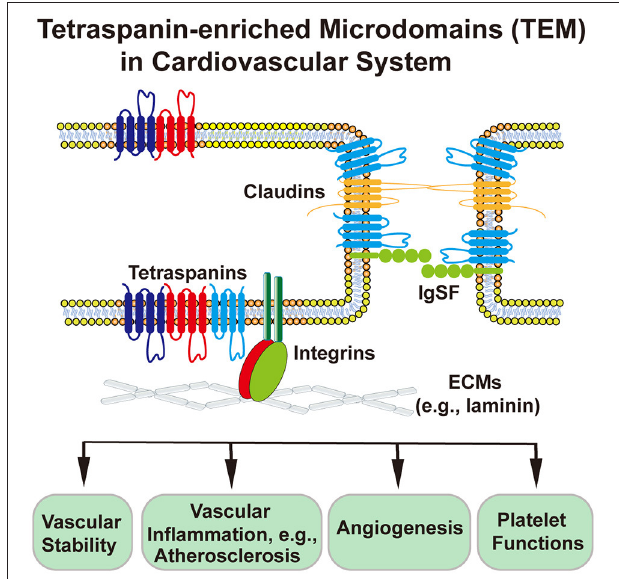
FIGURE 1 | Schematic presentation of tetraspanin-enriched microdomains (TEMs) at the cell–ECM and cell–cell interfaces and TEM-involved or TEM-regulated cardiovascular functions. Endothelial cell is used as an example of cardiovascular cells. In endothelial cells, tetraspanins associate with each other and with integrins, claudins, and IgSF proteins, to regulate physiological and pathological activities of heat, vessel, and blood.